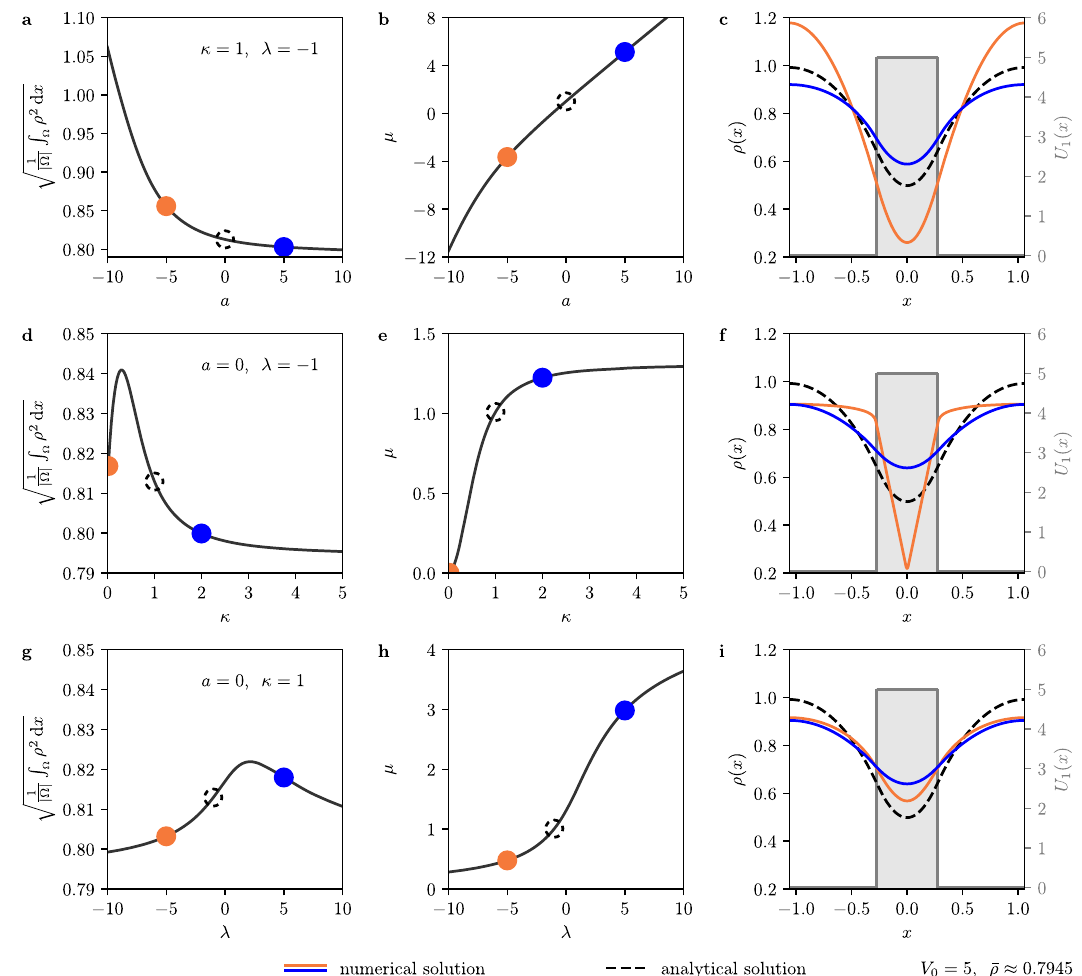
Fig. 2 | Results of the numerical continuation of Eq. (53). a – c Numerical con- tinuationwithcontrolparameter a with fi xedparametervalues κ = − λ =1.Theplots show a the L 2 -normof ρ asa functionof a , b the chemical potential μ asa function of a , and c density pro fi les for selected parameter values as indicated by circles of corresponding colors in a and b , compared to the analytical solution (47) (dashed